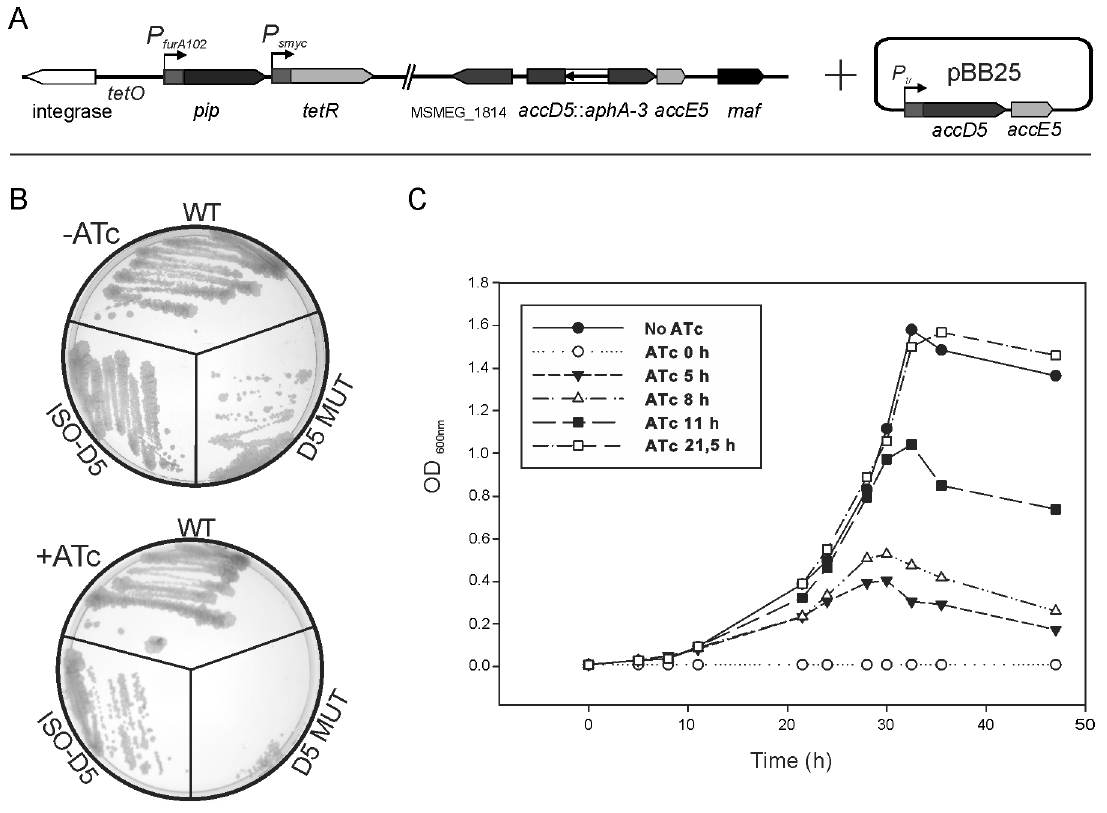
Figure 3. accD5-accE5 conditional mutant D5 MUT. A) Schematic representation of the genetic organization of the M. smegmatis conditional mutant D5 MUT. In pBB25, transcription of the accD5-accE5 operon is controlled by P tr , which can be repressed with the addition of ATc to the media. B) M. smegmatis mc 2 155 (WT), Isogenic (ISO-D5) and D5 MUT strains were grown on plates with 200 ng ml 2 1 ( + ATc) or without ATc ( 2 ATc). C) Growth curves of D5 MUT in the presence or absence of ATc 200 ng ml 2 1 . A saturated culture of D5 MUT grown at 37 u C was diluted in fresh 7H9 medium to an OD 600 nm of 0.01 and further incubated at 37 u C. After 5, 8, 11 and 21 h; an aliquot of the main culture was separated and supplemented with ATc 200 ng ml 2 1 . Growth was followed by measuring OD 600 nm